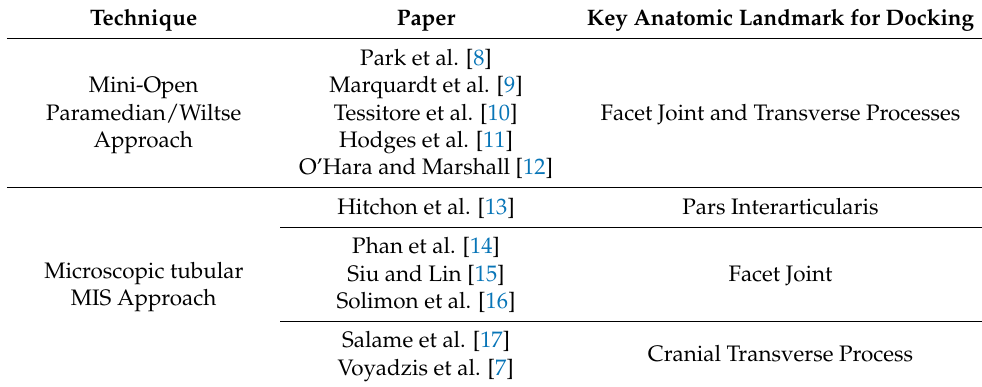
Table 1. Comprehensive literature review of techniques with various key anatomic landmarks used. Technique Key Anatomic Landmark for